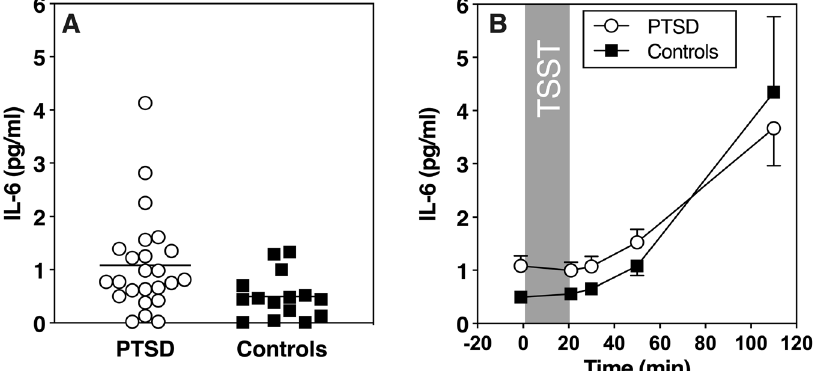
Fig. 3 Plasma in fl ammatory activity and reactivity to acute psychosocial stress. a Interleukin-6 (IL-6) baseline and b stress response to TSST. a Shows individual data points and mean, b shows mean and